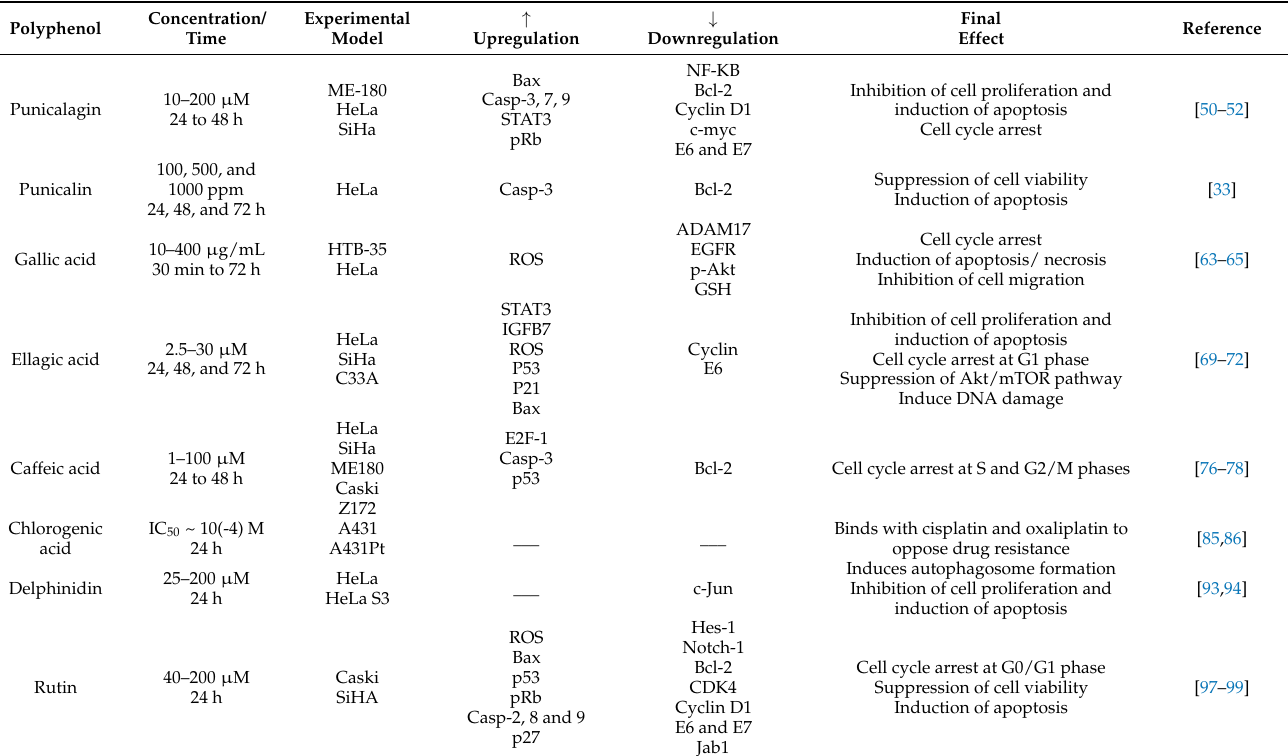
Table 2. Modulatory polyphenol impact on signaling pathways in cervical cancer cell